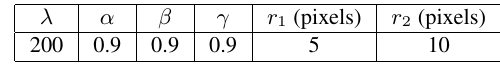
Table 1: Parameters for